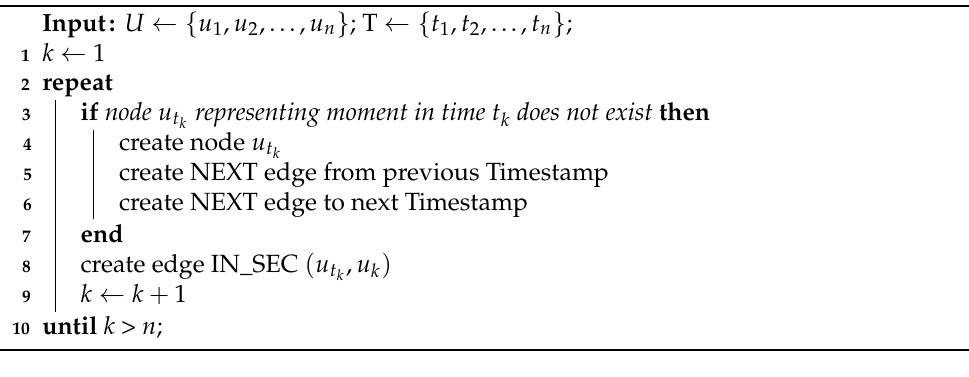
Algorithm 5: Assigning signal values to timestamps